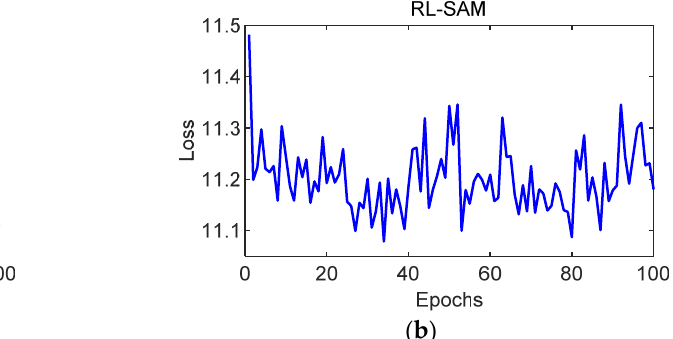
environments, and we only use one DIRL-SAM model to solve all mission planning problems with varying combat requirements and locations. That is, our proposed DIRL- SAM is robust for the UAV cluster mission planning problem.